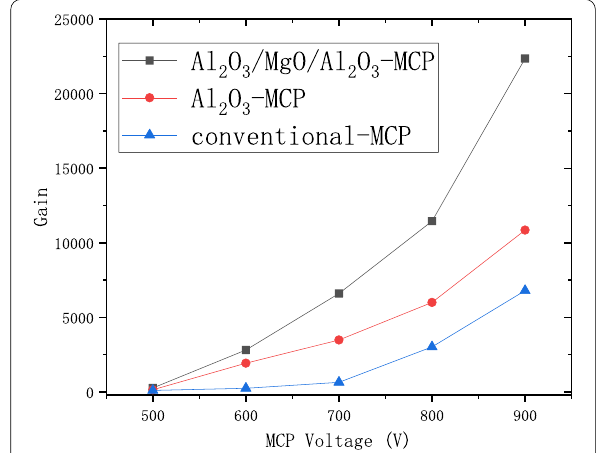
Fig.14 Relationship between the voltage and gain of the three microchannel plates (conventional microchannel plate, microchannel plate for growing Al 2 O 3 emission layer, microchannel plate for growing Al 2 O 3 /MgO/Al 2 O 3 emission